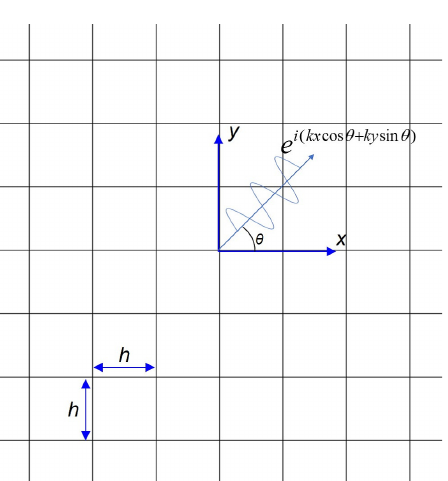
Figure 1. Two-dimensional plane wave propagation in a free field under a polar coordinate system discretized by square finite elements (FEs) with element size of h for dispersion